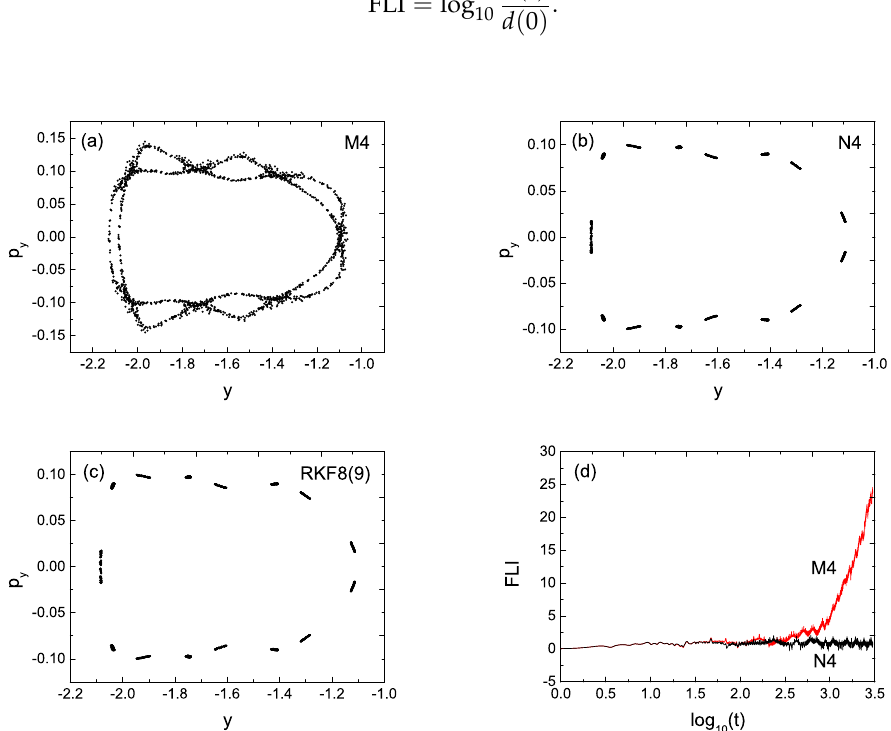
Figure 4. ( a – c ): Same as Figure 3 but for different initial values y = − 1.108 and p x . The orbit for M4 in ( a ) seems to be a chaotic many-islands torus, but the orbits for N4 and RKF8(9) in ( b , c ) are regular many-islands tori only. ( d ) Fast Lyapunov indicators (FLIs) for the two methods M4 and N4 integrating the orbit. The FLIs given by RKF8(9) are almost the same as those given by N4. When the integration ends, the FLI is smaller than 2.5 for N4, but reaches 25 for M4. The FLI for N4 indicates the regularity, while the FLI for M4 shows the chaoticity. The results are correct for N4, whereas chaos for M4 is spurious in panels ( a , d ) due to the large time step τ = 0.1 leading to M4 with poor accuracy to the numerical